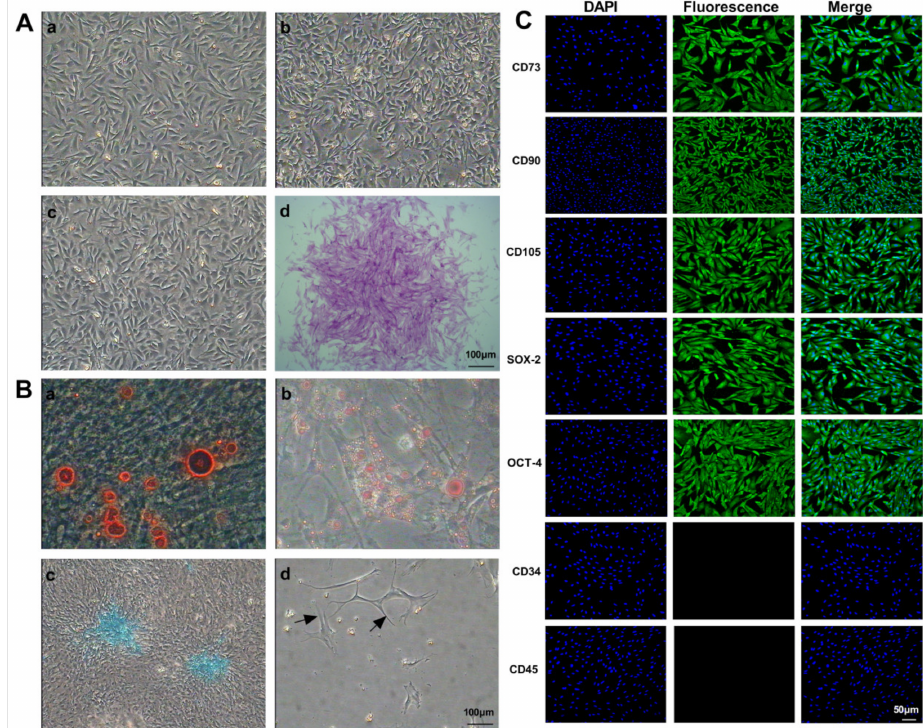
Figure 1. Biological characteristics of mouse GMSCs. ( A ) Morphology of GMSCs. (A-a) Cells that were initially round or irregularly shaped began to attach to the surface after primary culture for 24 h. (A-b) Generally, after 2–3 passages, morphological differences disappeared, and all cells exhibited a fibroblast-like morphology. (A-c) Typically, primary cells proliferated to 80–90% confluence after culture for 5–7 days; then, GMSCs proliferated rapidly and could be subcultured every 1–2 days. (A-d) Spindle-shaped GMSCs gave rise to colonies. ( B ) Detection of the multilineage differentiation potential of mouse GMSCs. (B-a) Detection of Alizarin Red staining. (B-b) Detection of Oil Red O staining. (B-c) Detection of Alcian Blue staining. (B-d) Morphological changes in GMSCs under neurogenic induction conditions after 21 days. Black arrows indicate that GMSCs grew numerous branches and formed many synapses on the cell surface. ( C ) Immunofluorescence staining for GMSC surface antigens, including CD73, CD90, CD105, Sox-2, OCT-4, CD34, and CD45.